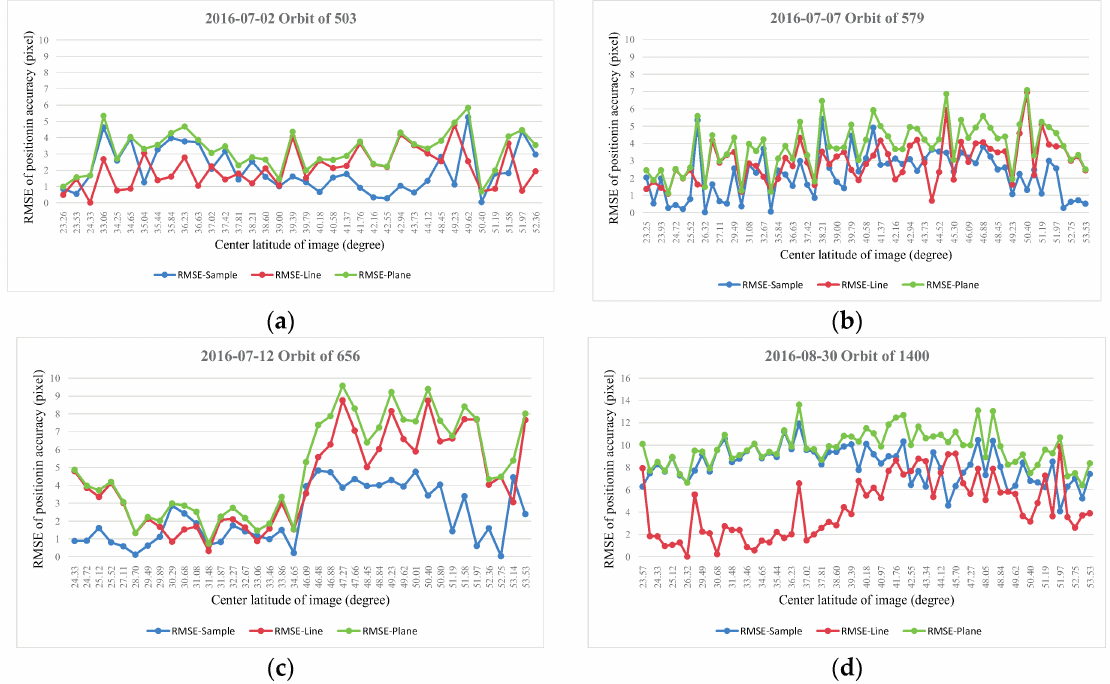
Figure 10. ( a – d ) Root-mean-square error (RMSE) of the absolute positioning accuracy without using GCPs along the latitude of the NAD sensors for the four